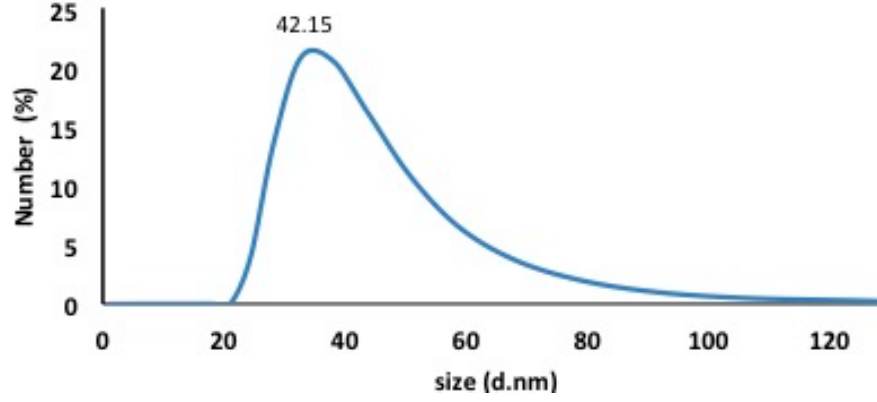
Figure 3. Particle size distribution shows 42.15 nm mean particle size.